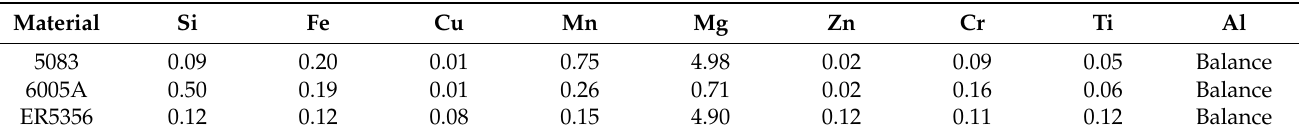
Table 1. Chemical compositions of the 5083 and 6005A aluminum alloys and the ER5356 filler metal (wt.